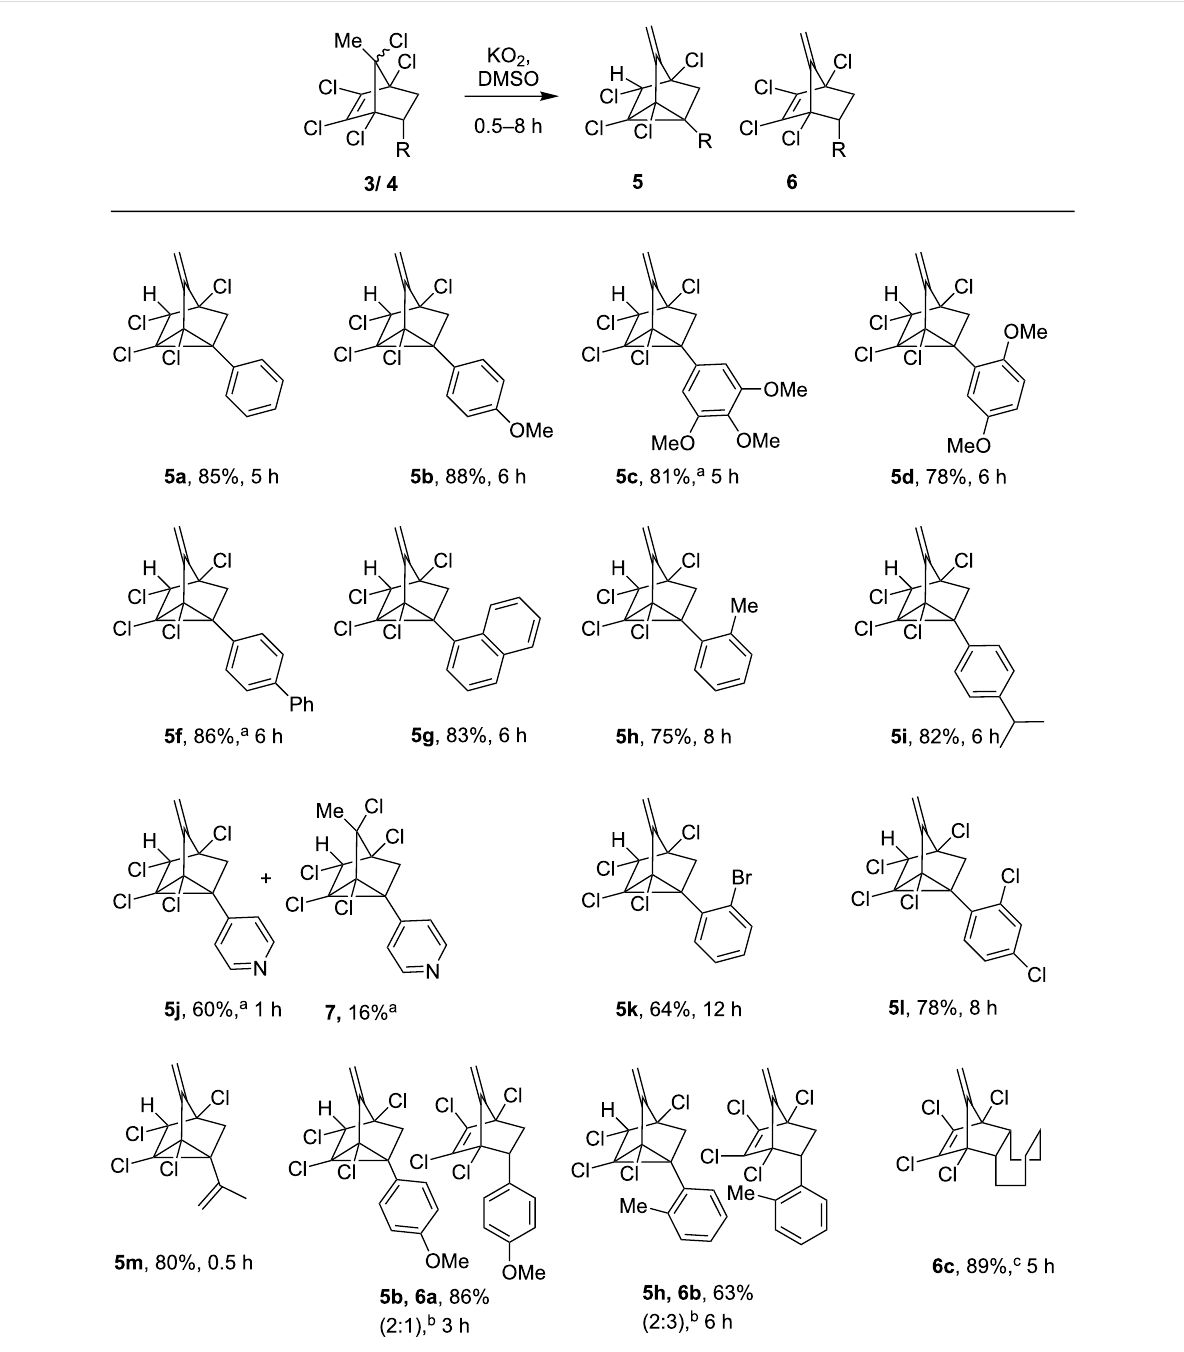
Scheme 2: KO 2 -mediated synthesis of tetrachloro-substituted 3-methylenenortricyclenes. Reaction conditions: All the substrates are a mixture of syn and anti with KO 2 (3 equiv)/DMSO at 60 °C, isolated yields are given. a Reaction performed at rt, b syn -isomers 4b and 4h gave mixtures of 5 and 6 . c Reaction performed at 100